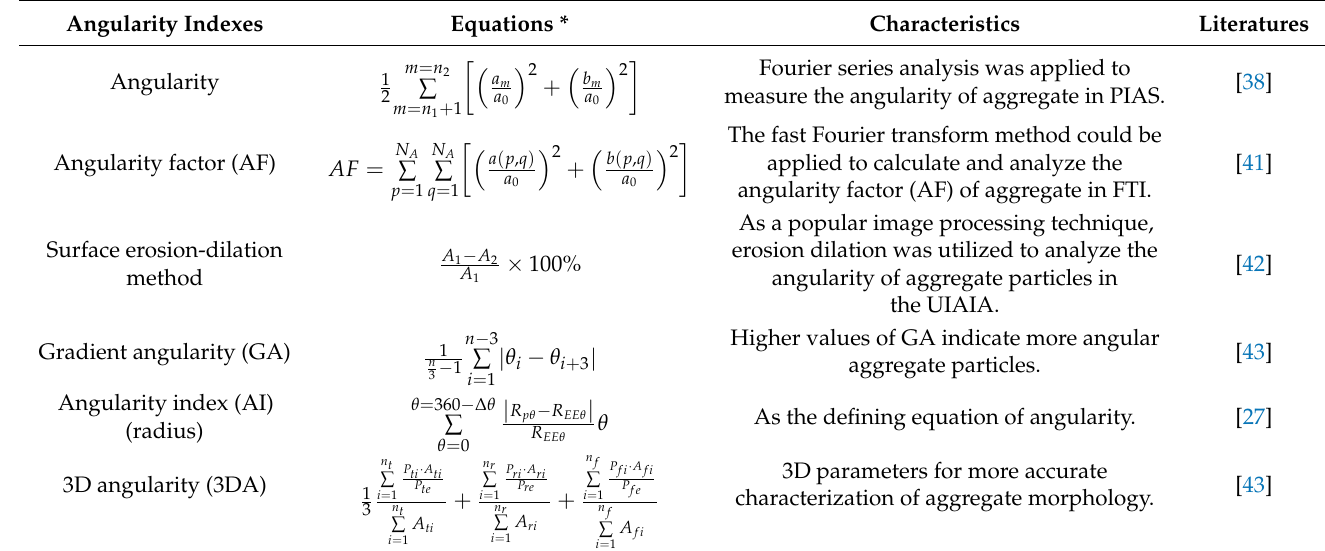
Table 2. Angularity index of aggregate with calculation equations and main characteristics. Angularity Indexes Equations * Characteristics